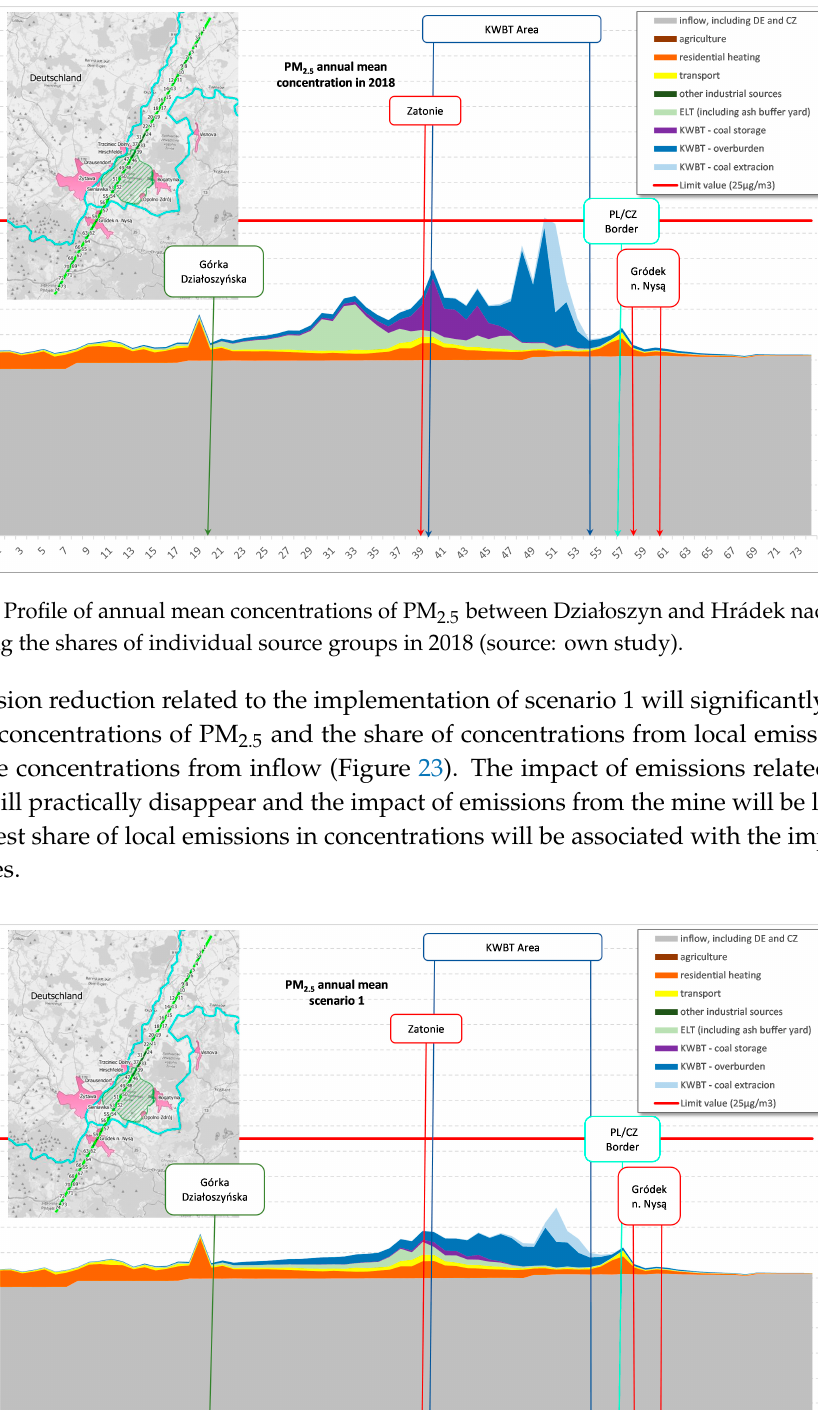
Figure 23. Profile of annual mean concentrations of PM 2.5 between Dzia ł oszyn and Hrádek nad Nisou, considering the shares of individual source groups for scenario 1 (source: own study).